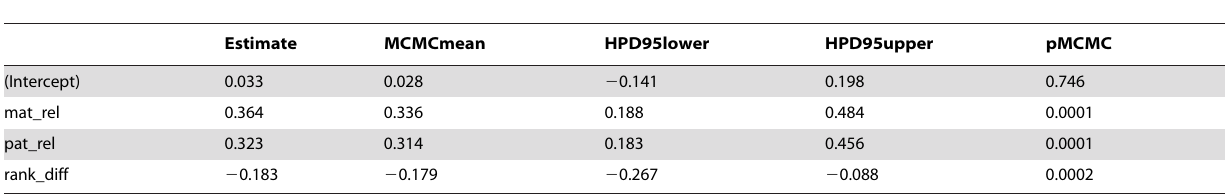
Table 2. Predictors of the strength of social bonds (CSI) between female rhesus macaques.